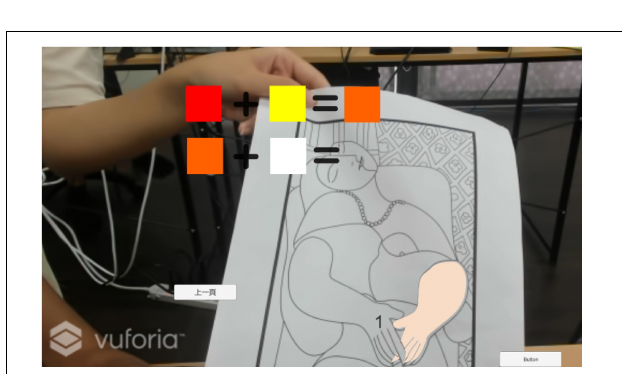
FIGURE 2 | Experimental group learners’ actual paintings through smart glasses.